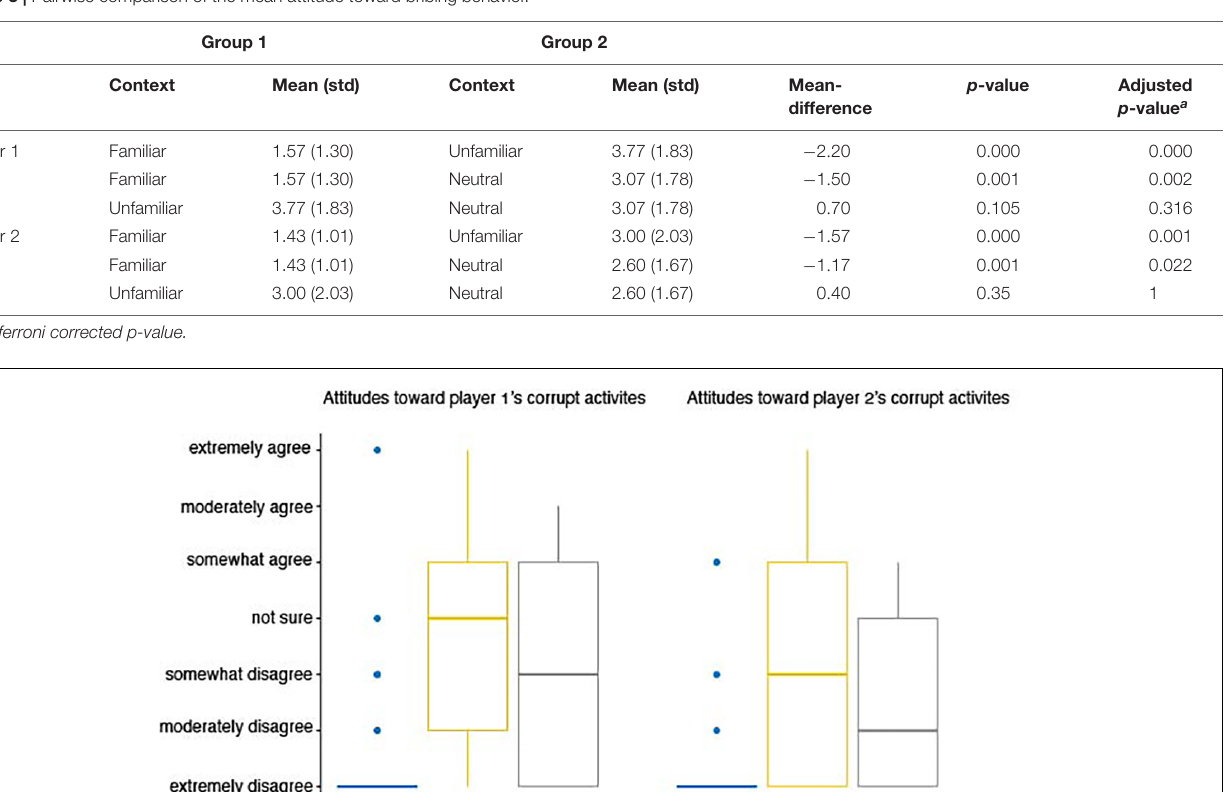
Table 3 | Pairwise comparison of the mean attitude toward bribing behavior.